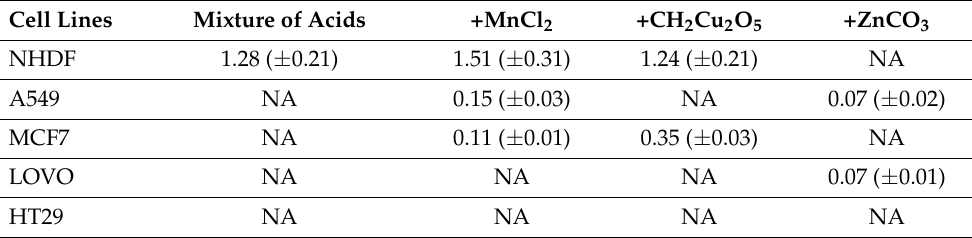
Table 18. IC50 values against normal and tumour lines incubated for 48 h with rosemary essential oil ( Rosmarinus officinalis ) and the components used in the